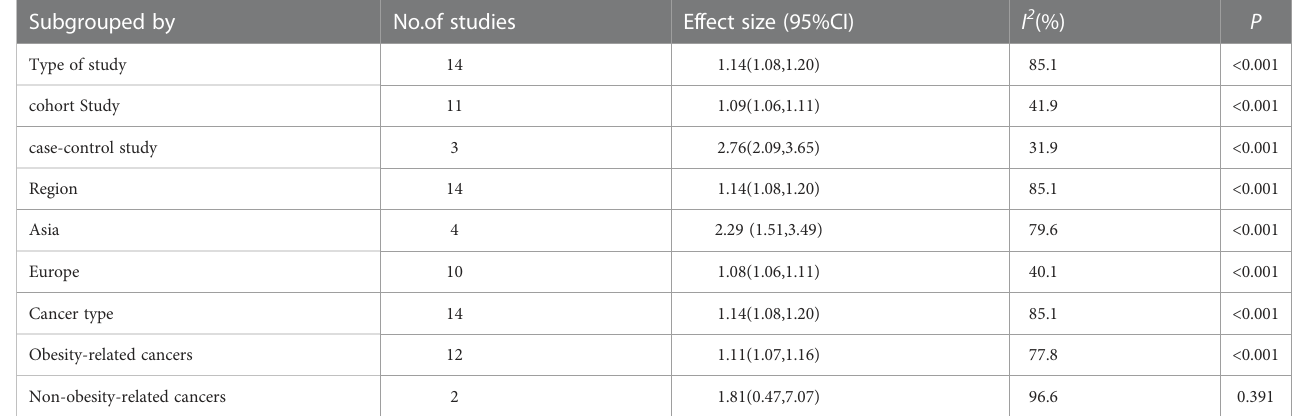
TABLE 3 Results of subgroup analyses.